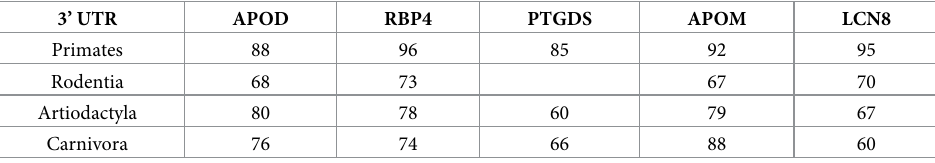
Table 3. Sequence similarity 3’